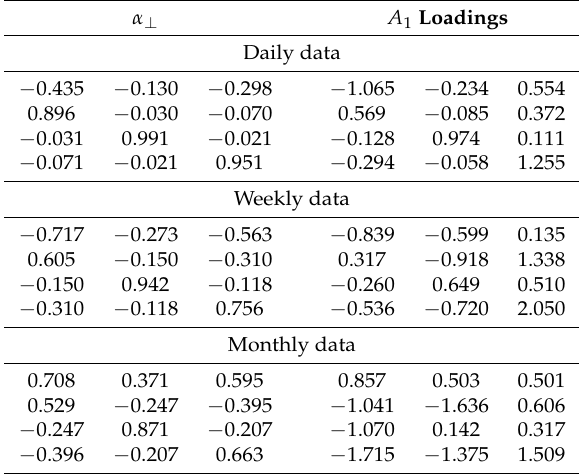
Table 10. Estimated parameters for the Gonzalo–Granger permanent-transitory decomposition of EUA, coal, gas and Brent given by Equations (4) and (5). α ⊥